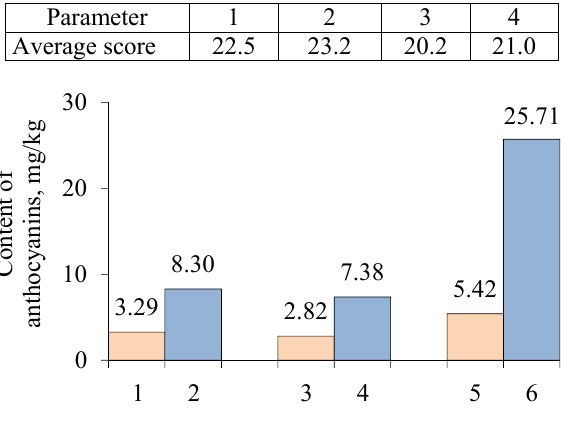
Fig. 1. Content of anthocyanins (mg/kg) in bran and the finished products in terms of cyanidin-3-glucoside (numbers 1–6 of products are according Table 1).